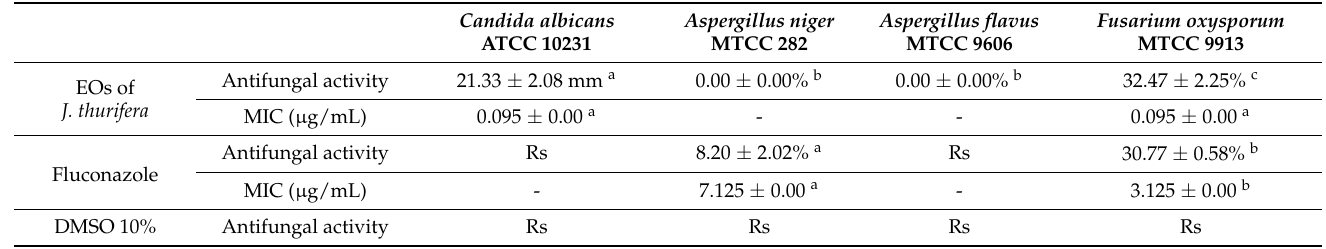
Table 3. Antifungal activity of J. thurifera EOs in comparison with fluconazole. Candida albicans ATCC